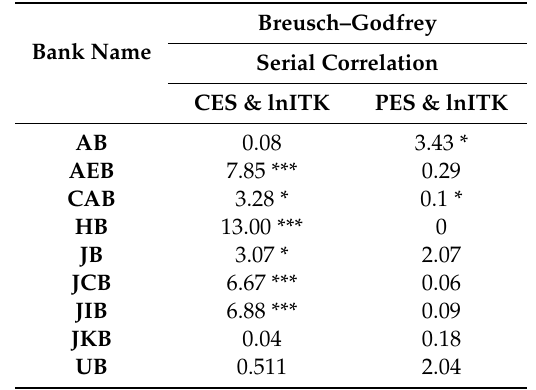
Table A2. Table A2. Diagnostic for serial autocorrelation using the Breusch–Godfrey LM test. Bank Name